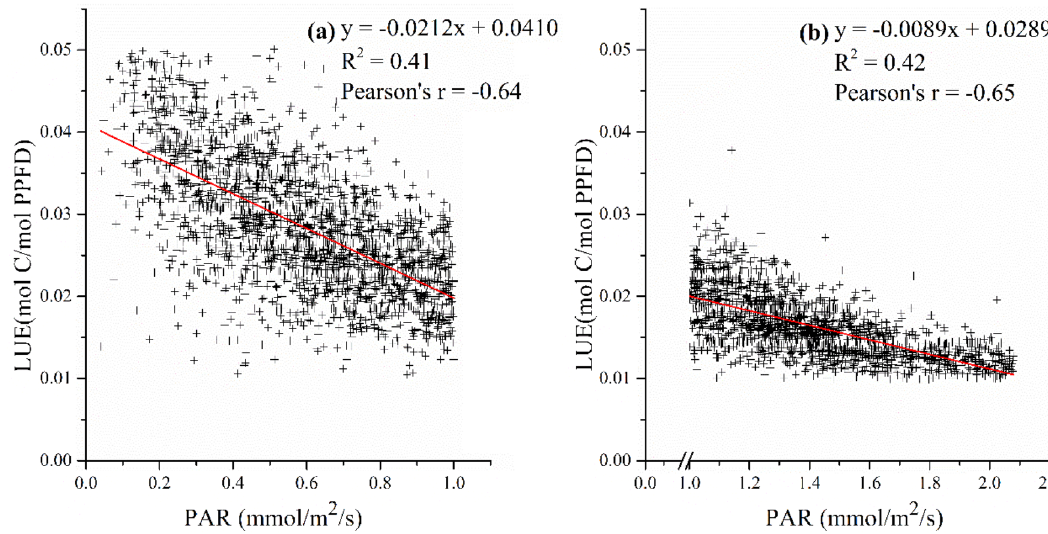
Figure 2. The response of LUE to PAR: ( a ) PAR = < 1 mmol/m 2 /s and ( b ) PAR > 1 mmol/m 2 /s.